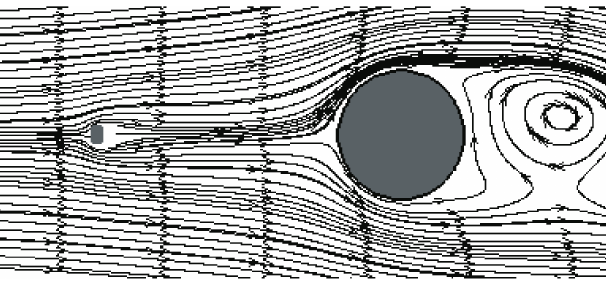
Figure 4. Type-I circular cylinder as a passive control at the front of the main object.